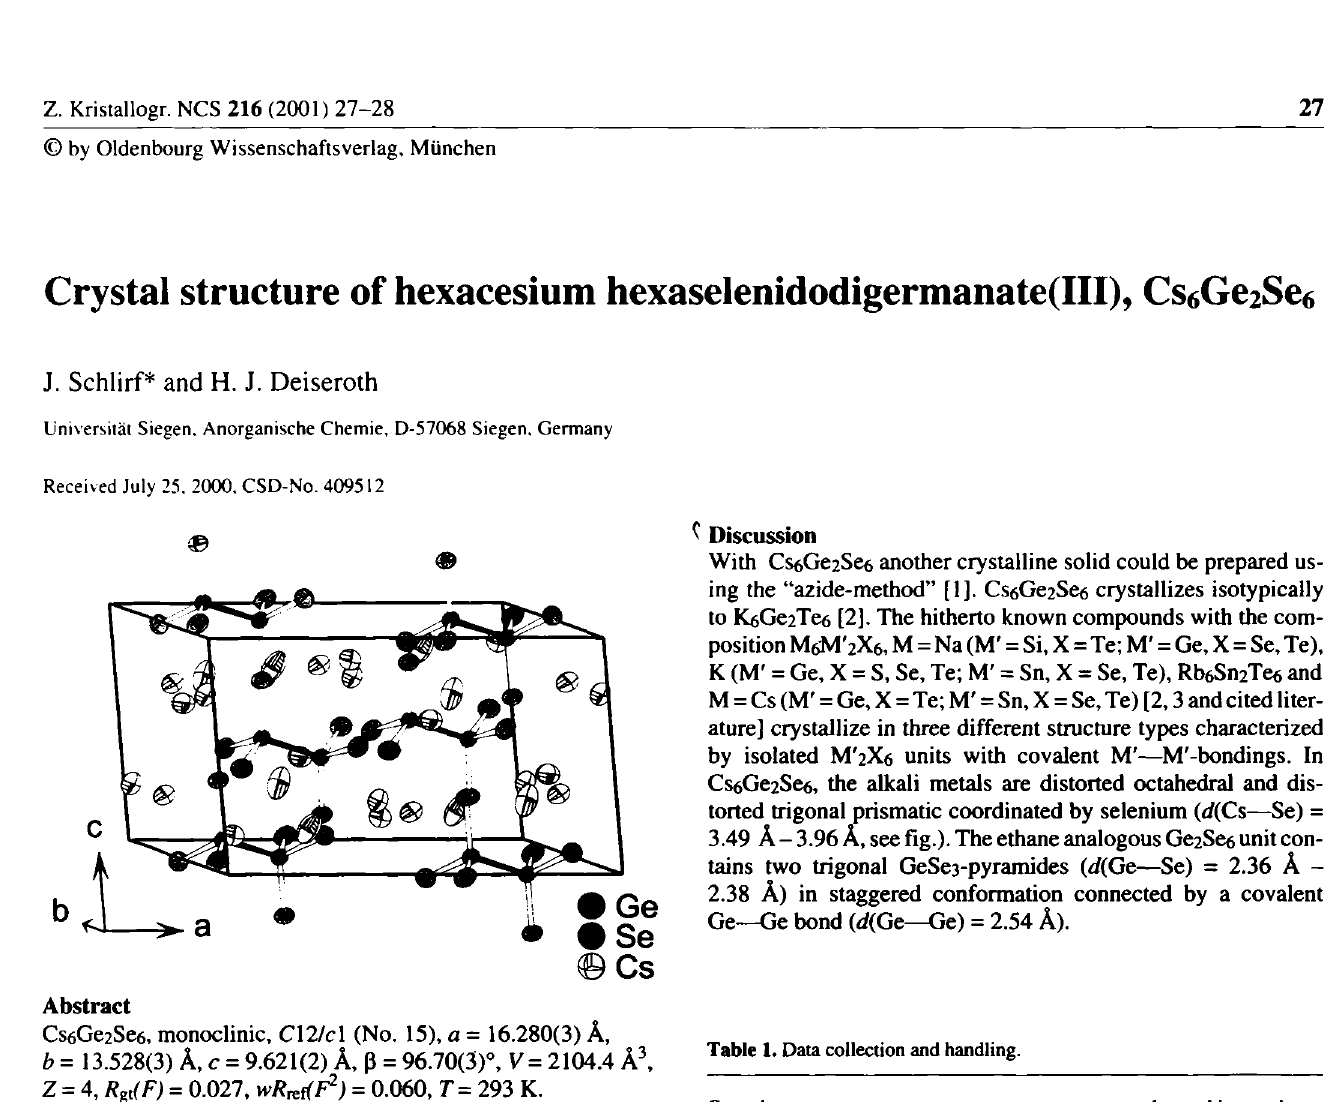
Table 1. Data collection and